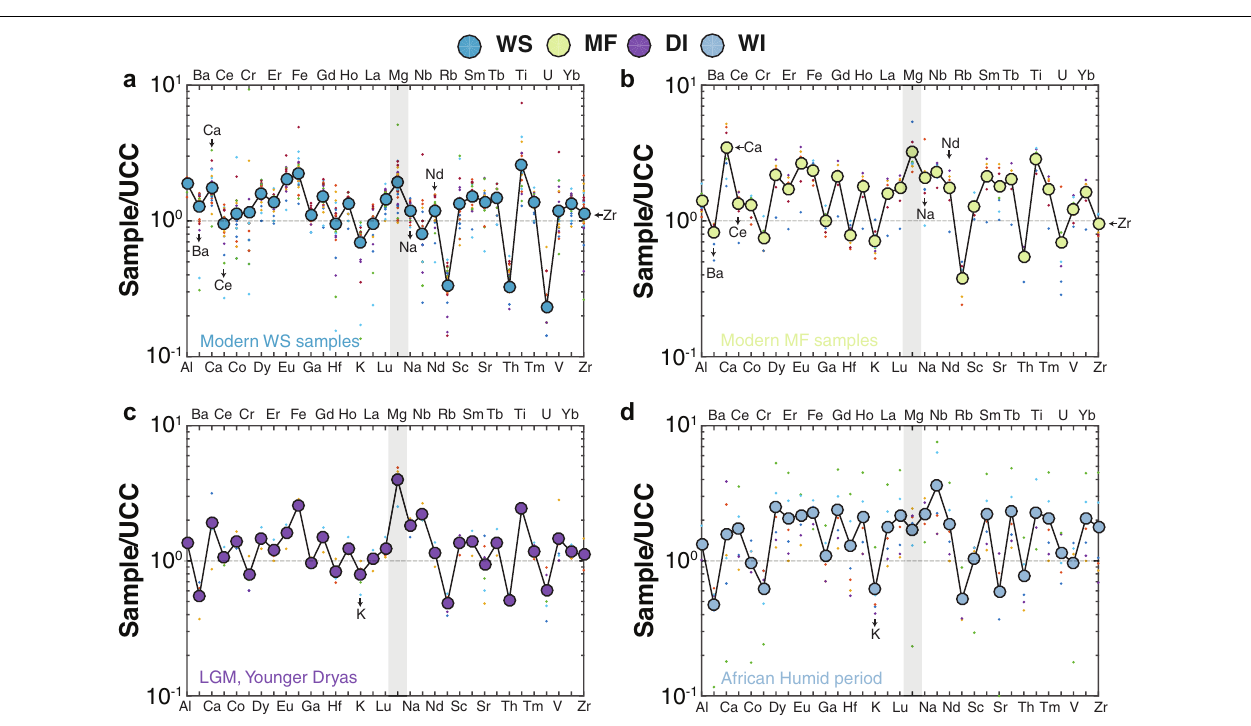
FIGURE 7 | Upper Continental Crust (UCC)-normalized (McLennan, 2001) chemical composition in (a) WS, (b) MF, (c) DI, and (d) WI samples. Colored dots show the individual averages for each sample group. WS, modern watershed; MF, modern mudflat; MF, modern mudflat; DI, late Quaternary dry interval; and WI, late Quaternary wet